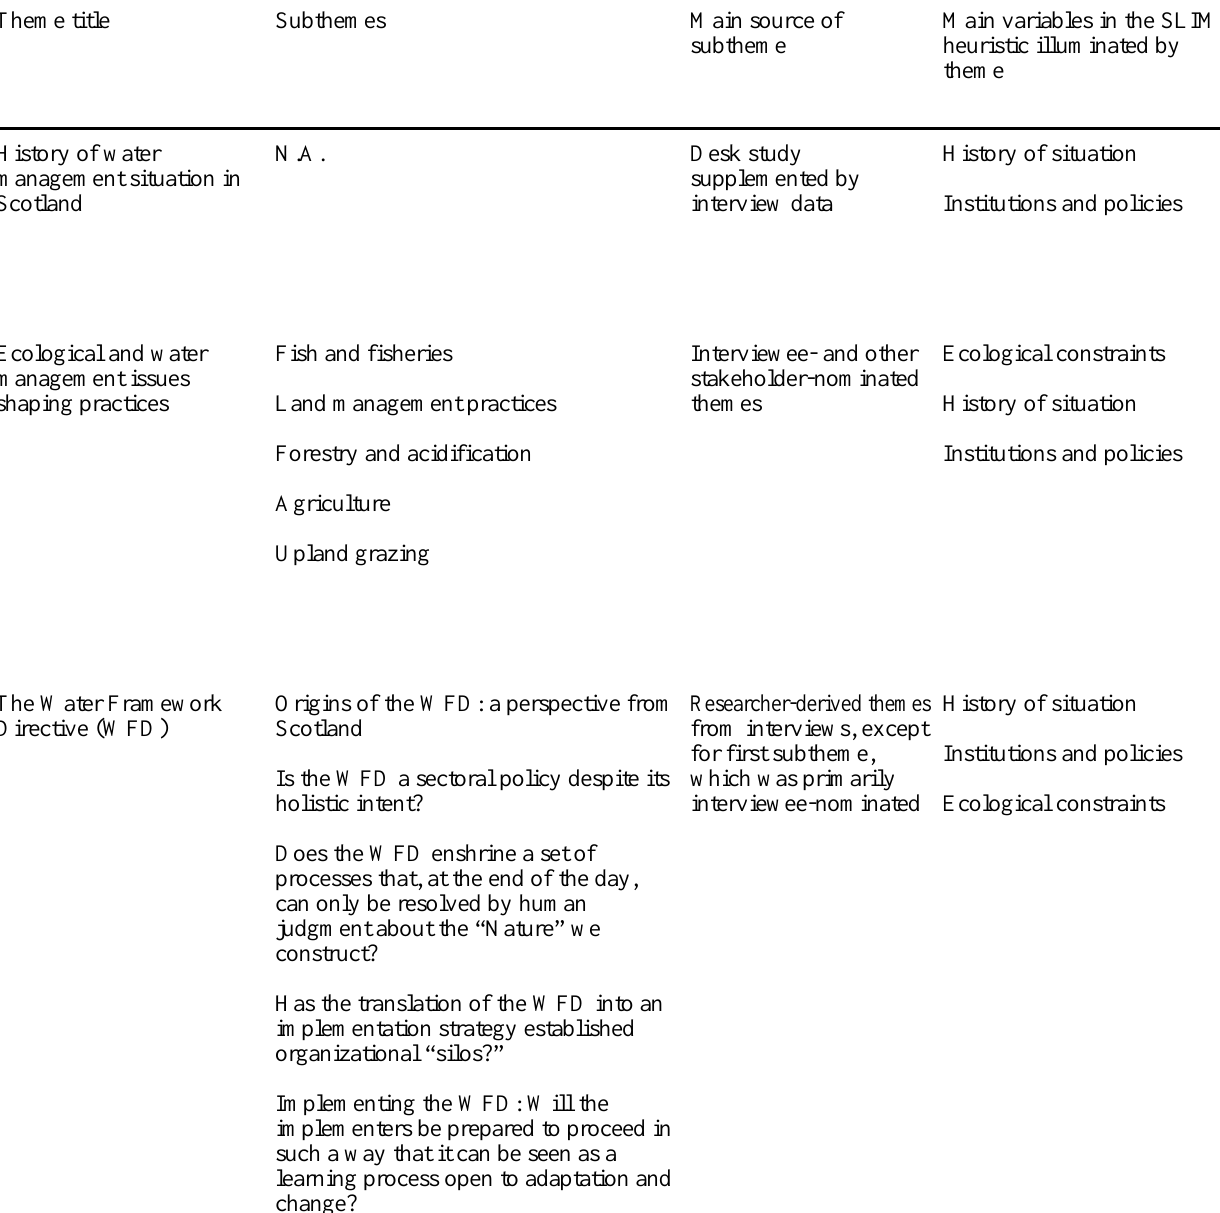
Table A2-1. The main themes and subthemes to emerge from the Scottish policy context case study, the source for naming these themes/subthemes, and the main SLIM variables that are illuminated by a